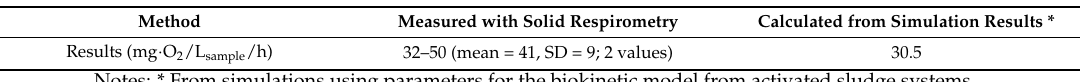
Table 5. Comparison of measured and calculated volumetric nitrification rates (adapted from [43], SD = standard deviation).